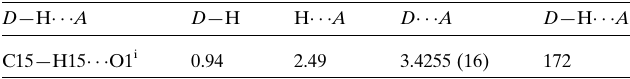
Table 1 Hydrogen-bond geometry (A˚ , (cid:2) ).